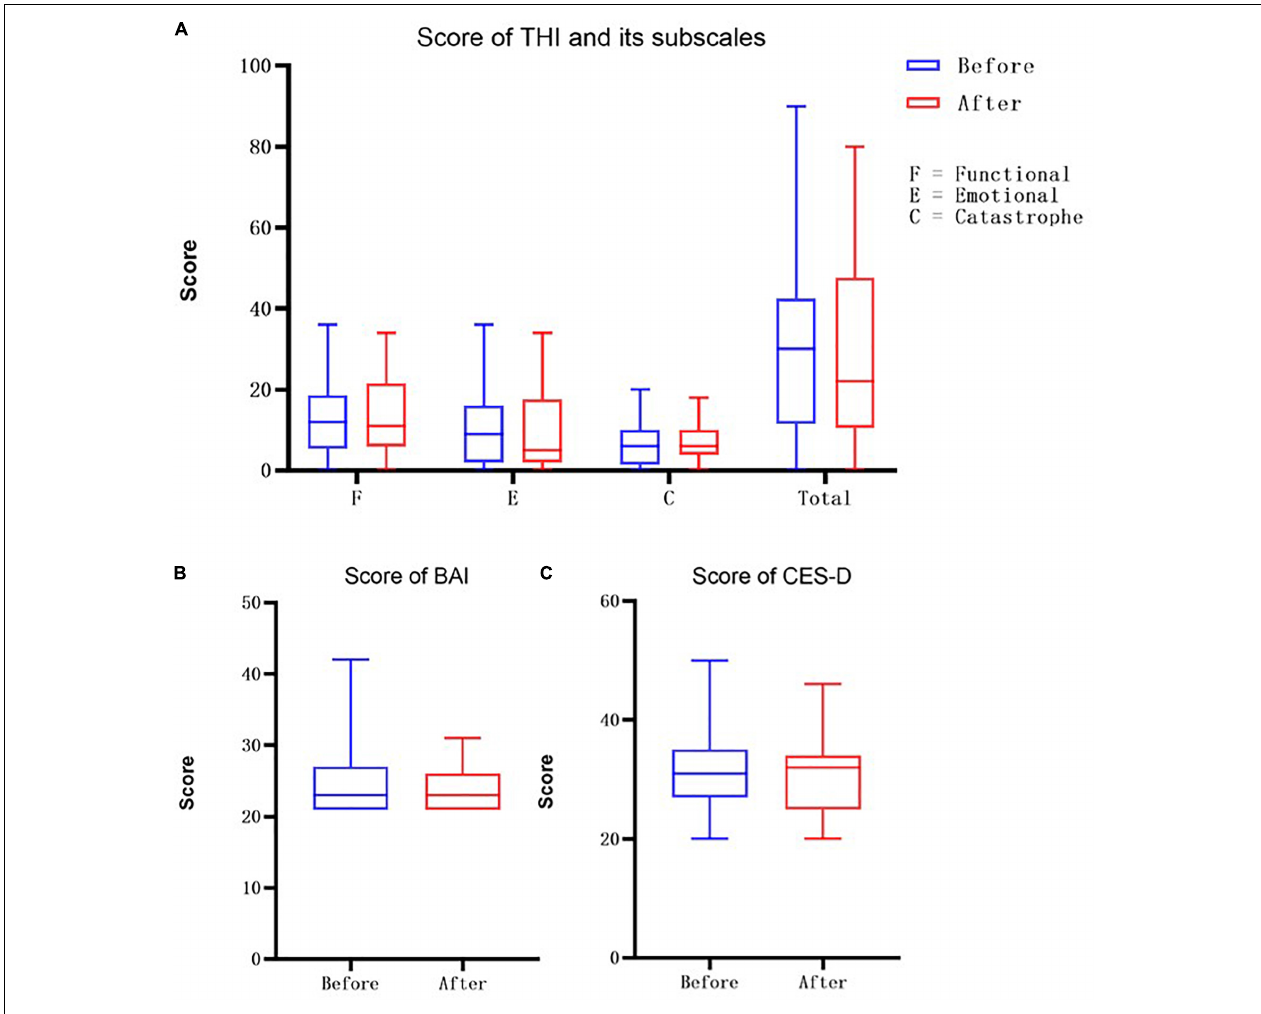
FIGURE 3 | (A) Here is the score of THI scale, where F represents the functional score, E represents the emotional score, and C represents the score of catastrophe, the last one represents the Total THI score. The blue bars are the socres before the treatment and the red bars are the socres after receving the sound therapy. (B) The score of Beck Anxiety Inventory (BAI). (C) The score of Center for Epidemiologic Studies-Depression (CES-D)